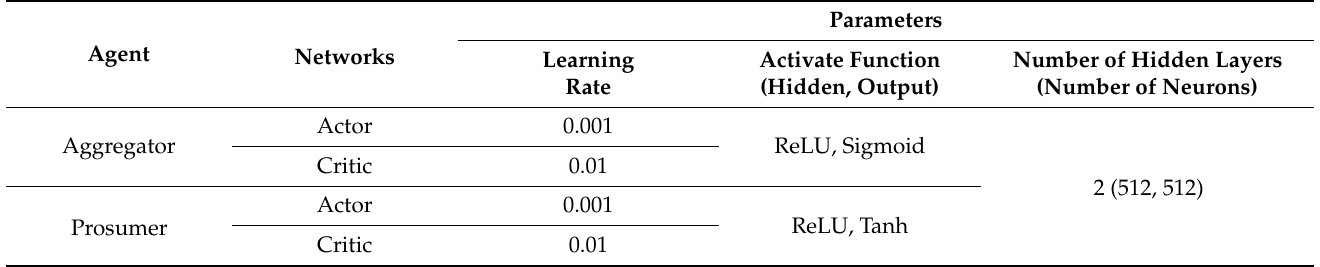
Table 2. The parameters of the aggregator and prosumer